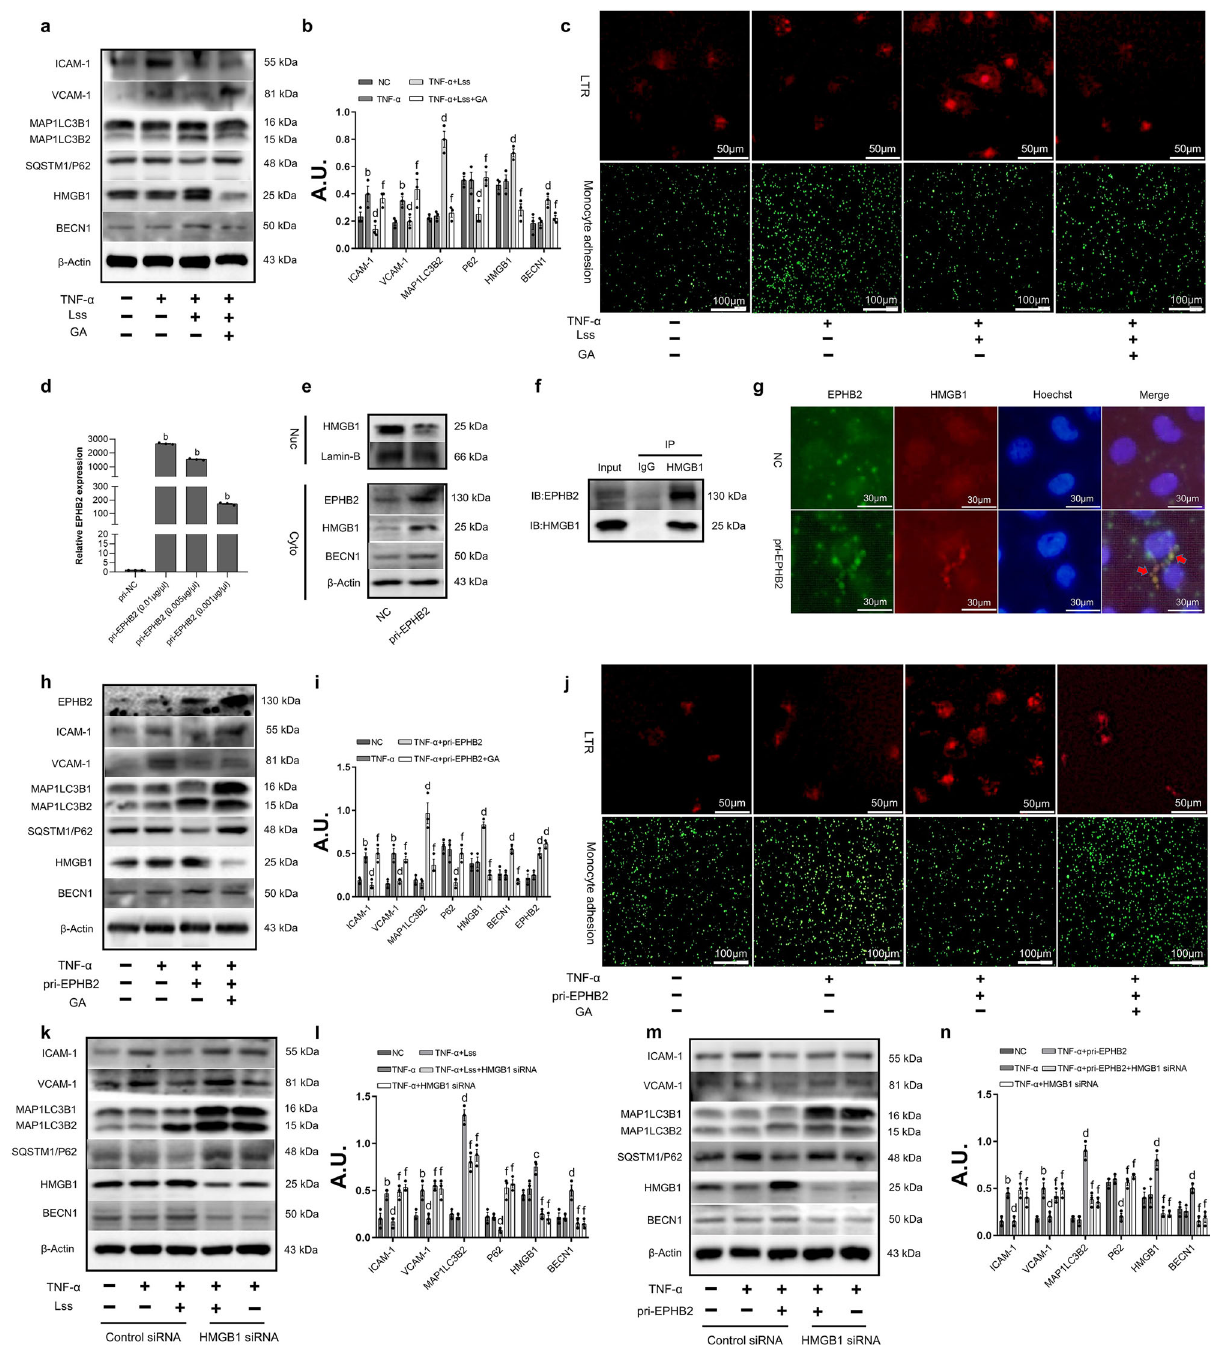
Fig. 4 Overexpression of EPHB2 can activate autophagy and exert the same anti-in fl ammatory effect as LSS. a , b Western Blot shows the effect of GA (100 μ M) on anti-in fl ammatory effect of LSS. c Confocal microscopy shows the effect of GA on LSS activated autophagy (HAECs stained with Lyso Tracker Red) and inhibited monocyte adhesion. d qRT-PCR shows the expression of EPHB2. e The nucleoplasmic separation experiment shows the subcellular localization of HMGB1 when EPHB2 was overexpressed. f Co-immunoprecipitation assay shows the physical interaction between HMGB1 and EPHB2 in HAECs when EPHB2 was overexpressed, and the cell lysates were immunoprecipitated by anti-HMGB1 antibody. g Immuno fl uorescence assay shows the co-localization of EPHB2 and HMGB1 in HAECs when EPHB2 was overexpressed. h , i Western Blot shows the effect of GA on anti-in fl ammatory effect of pri-EPHB2. j Confocal microscopy shows the effect of GA on pri-EPHB2 activated autophagy (HAECs stained with Lyso Tracker Red) and inhibited monocyte adhesion. k , l . Western Blot shows the effect of HMGB1 siRNA on anti-in fl ammatory effect of LSS. m , n . Western Blot shows the effect of HMGB1 siRNA on anti-in fl ammatory effect of pri-EPHB2. Data are presented as mean ± SEM of three independent experiments. a P < 0.05, b P < 0.01 vs. NC group; c P < 0.05, d P < 0.01 vs. TNF- α group; e P < 0.05, f P < 0.01 vs. TNF- α + LSS or pri-EPHB2 group. AU, arbitrary